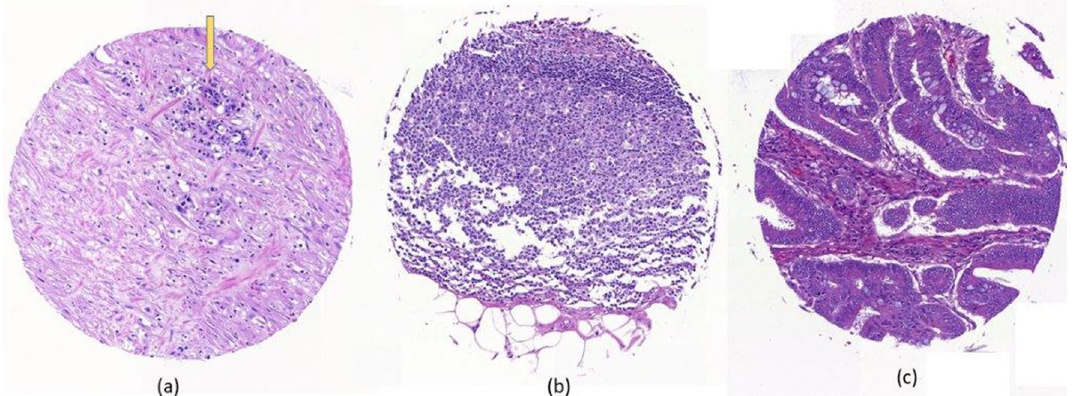
Figure 4. Example of some error classification where: ( a ) the case of small tumor area (yellow arrow) was predicted as other, ( b ) unseen tissue of complex tumor stroma was predicted as other, ( c ) adenoma case was predicted as tumor.